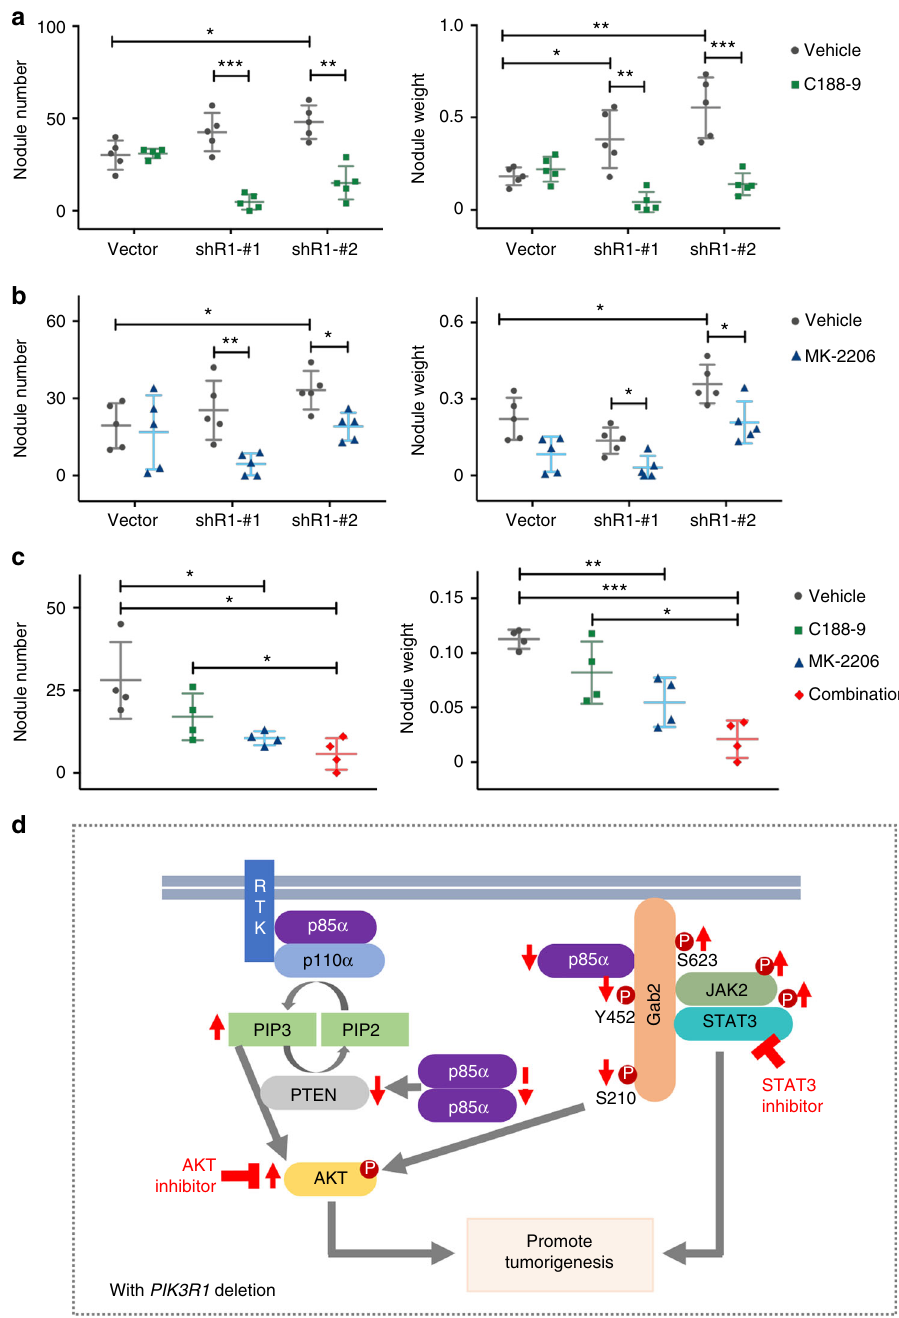
Fig. 8 STAT3 and AKT inhibitors suppress PIK3R1 loss-driven ovarian tumorigenesis. a , b Tumor-bearing mice ( n = 5) were treated with vehicles, STAT3 inhibitor C188-9 (28 mg/kg) ( a ) or AKT inhibitor MK-2206 (75 mg/kg) ( b ) for 3 weeks. c Tumor-bearing mice ( n = 4) were treated with vehicles, C188-9 (20 mg/kg) alone, MK-2206 (45 mg/kg) alone or in combination for 3 weeks. Bar graphs of tumor nodule number and weight are presented. Error bars represent SD. * p < 0.05; ** p < 0.005; *** p < 0.001 using t -test. d Proposed working model: p85 α in the PI3K heterodimeric complex stabilizes but